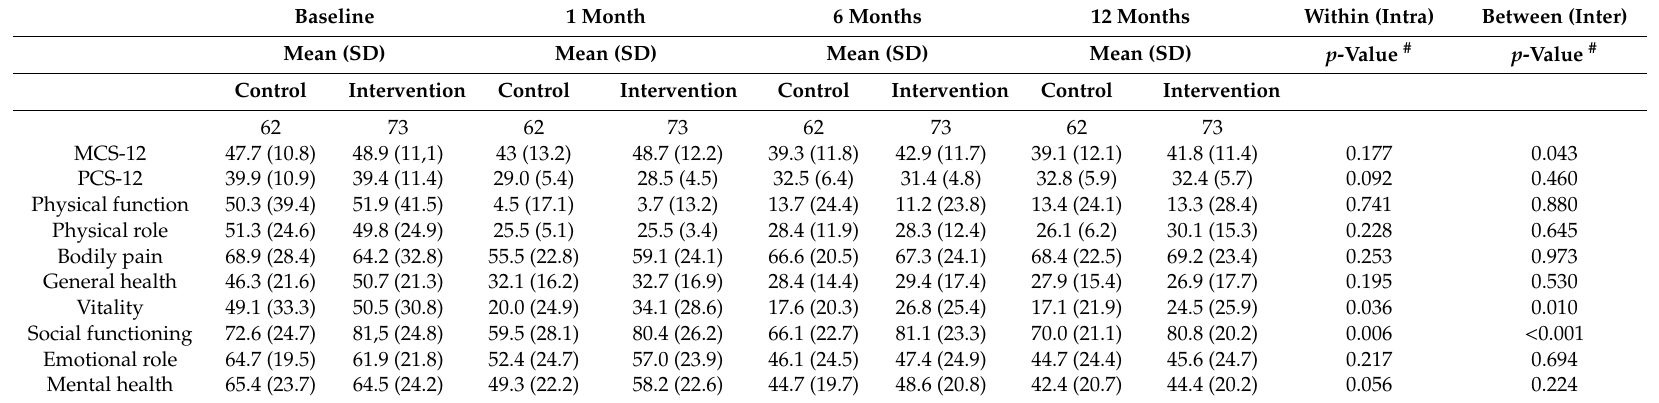
Table 2. Quality-of-life dimensions of the SF-12 health survey throughout the study: intervention vs. control group. MCS-12, Mental Component Summary; PCS-12, Physical Component